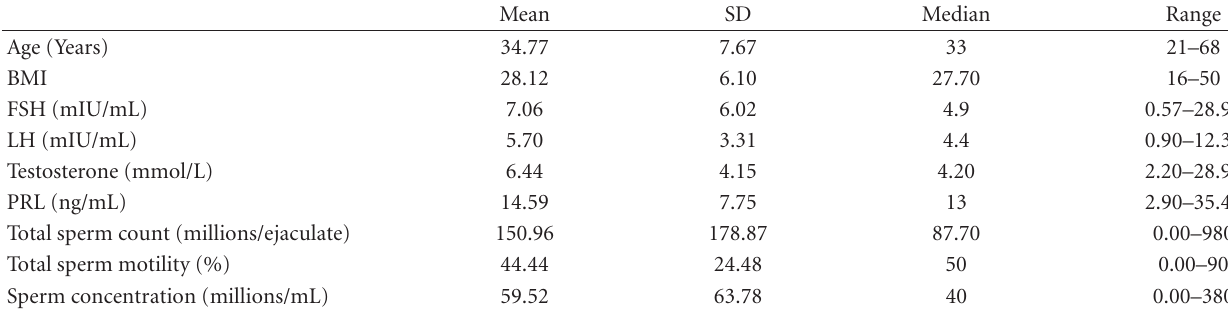
Table 1: Clinical hormonal and semen characteristics of subjects.